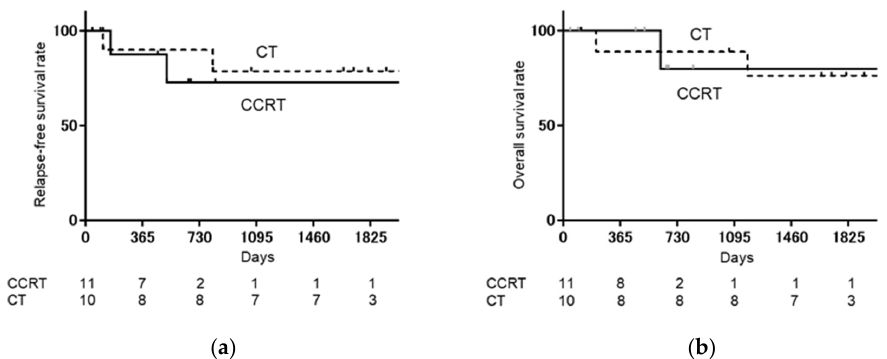
Figure 2. Kaplan–Meier analysis of relapse-free survival (RFS) and overall survival (OS) with single-lymph-node metastasis. ( a ) Kaplan–Meier analysis of relapse-free survival (RFS) with single-lymph-node metastasis. ( b ) Kaplan–Meier analysis of overall survival (OS) with single-lymph-node metastasis. The CCRT with single-lymph-node metastasis group is compared with the chemotherapy with single-lymph-node metastasis group, and there are no significant differences in RFS (log-rank: p = 0.6539, HR: 0.6481, 95%CI: 0.087–4.819) and OS (log-rank: p = 0.9795, HR: 0.9706, 95%CI: 0.086–10.84).